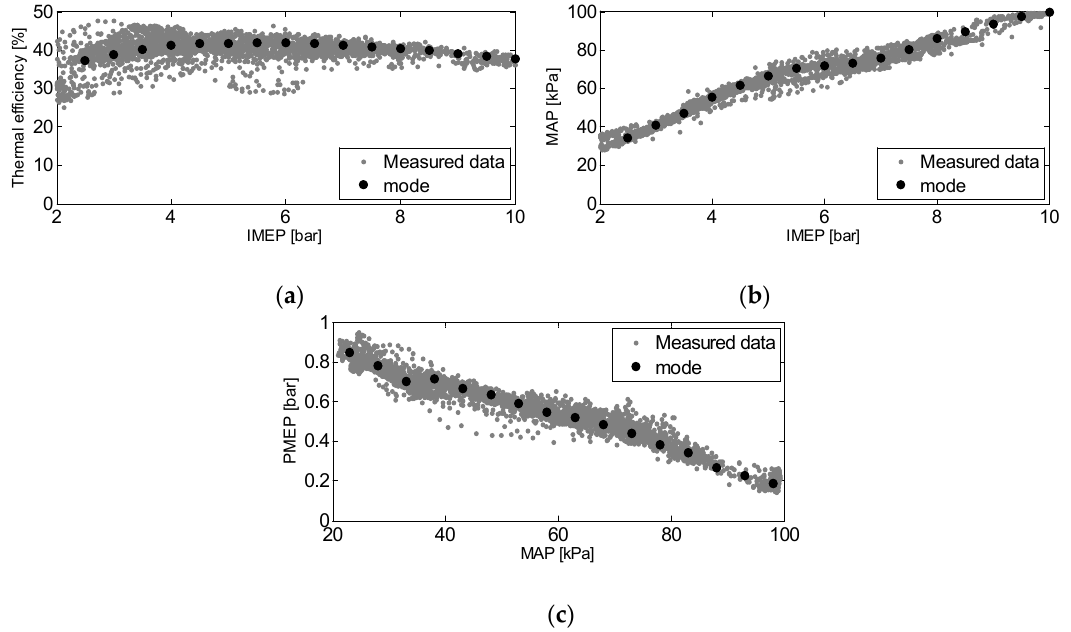
Figure 1. Test data analysis in phase 3 of FTP-75; ( a ) Modes of thermal efficiency divided by intervals; ( b ) Modes of manifold absolute pressure (MAP) divided by intervals; ( c ) Modes of pumping mean effective pressure (PMEP) divided by intervals.